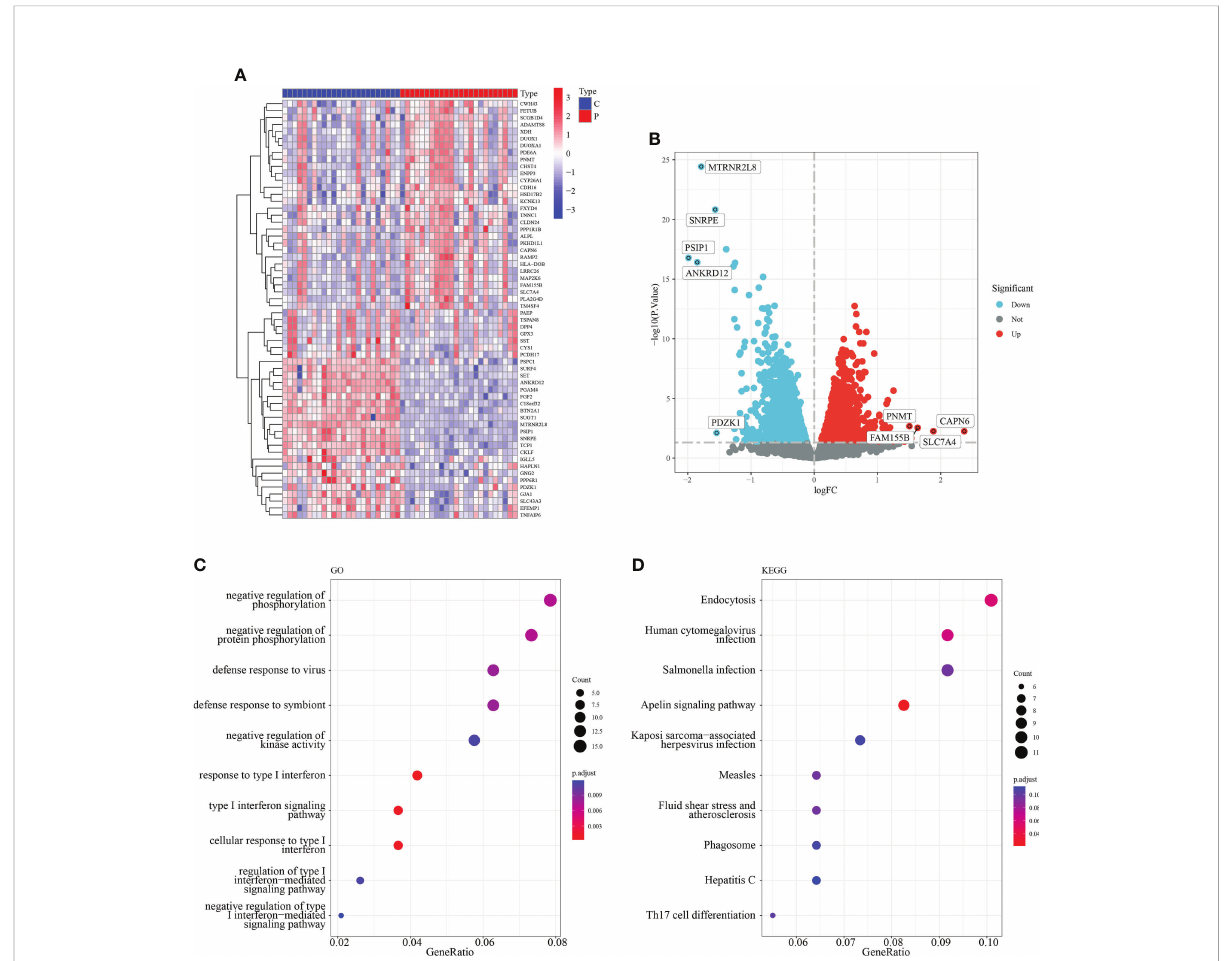
FIGURE 2 Identi fi cation of macrophage-related differentially expressed genes. (A) Heat map of the top 50 DEG. (B) Volcano plot of DEG. (C) GO enrichment analysis of DEG. (D) KEGG enrichment analysis of